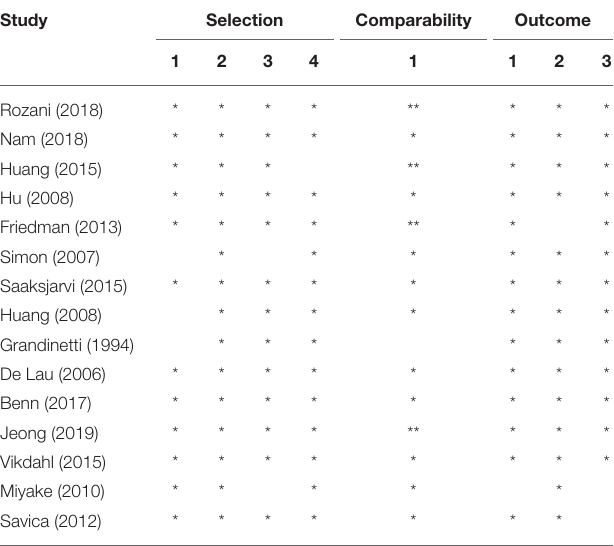
TABLE 1 | Quality assessment of each eligible study according to the NOS. Study